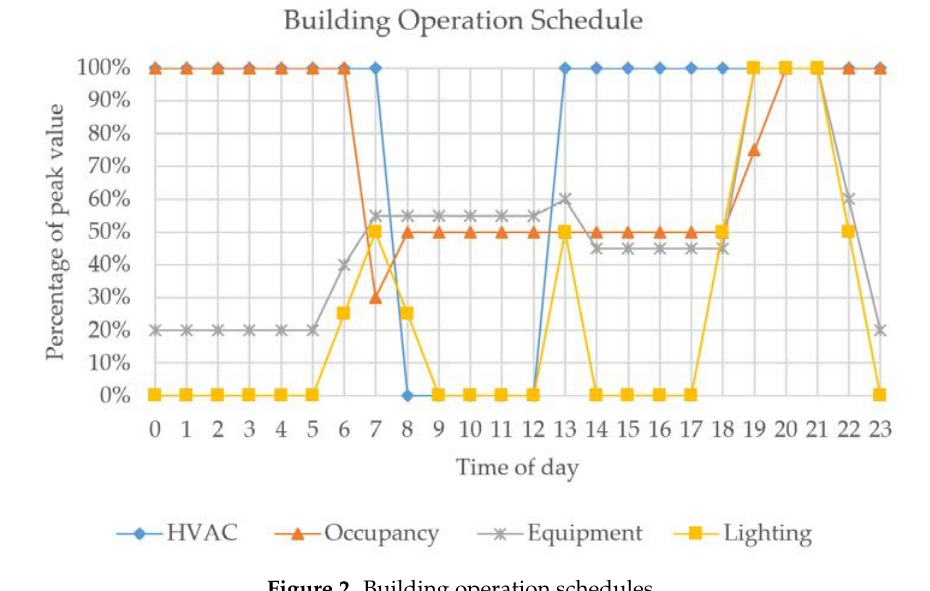
Figure 2. Building operation schedules. Table 1. General construction and building material data.